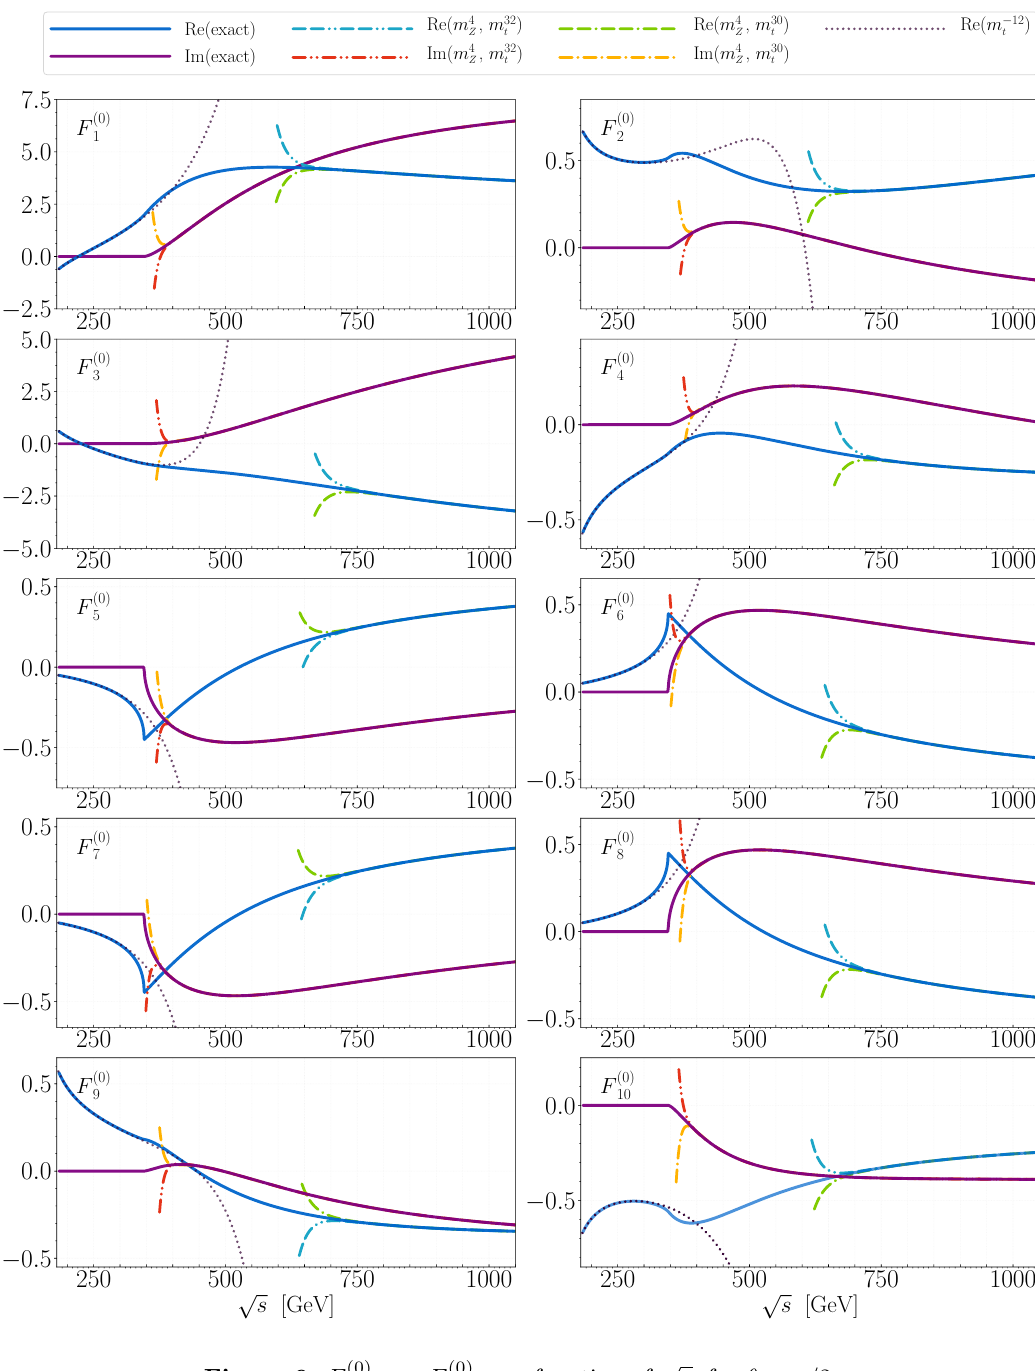
; : : : ; F (0) as a function of p s , for (cid:18) = (cid:25)= 1 10